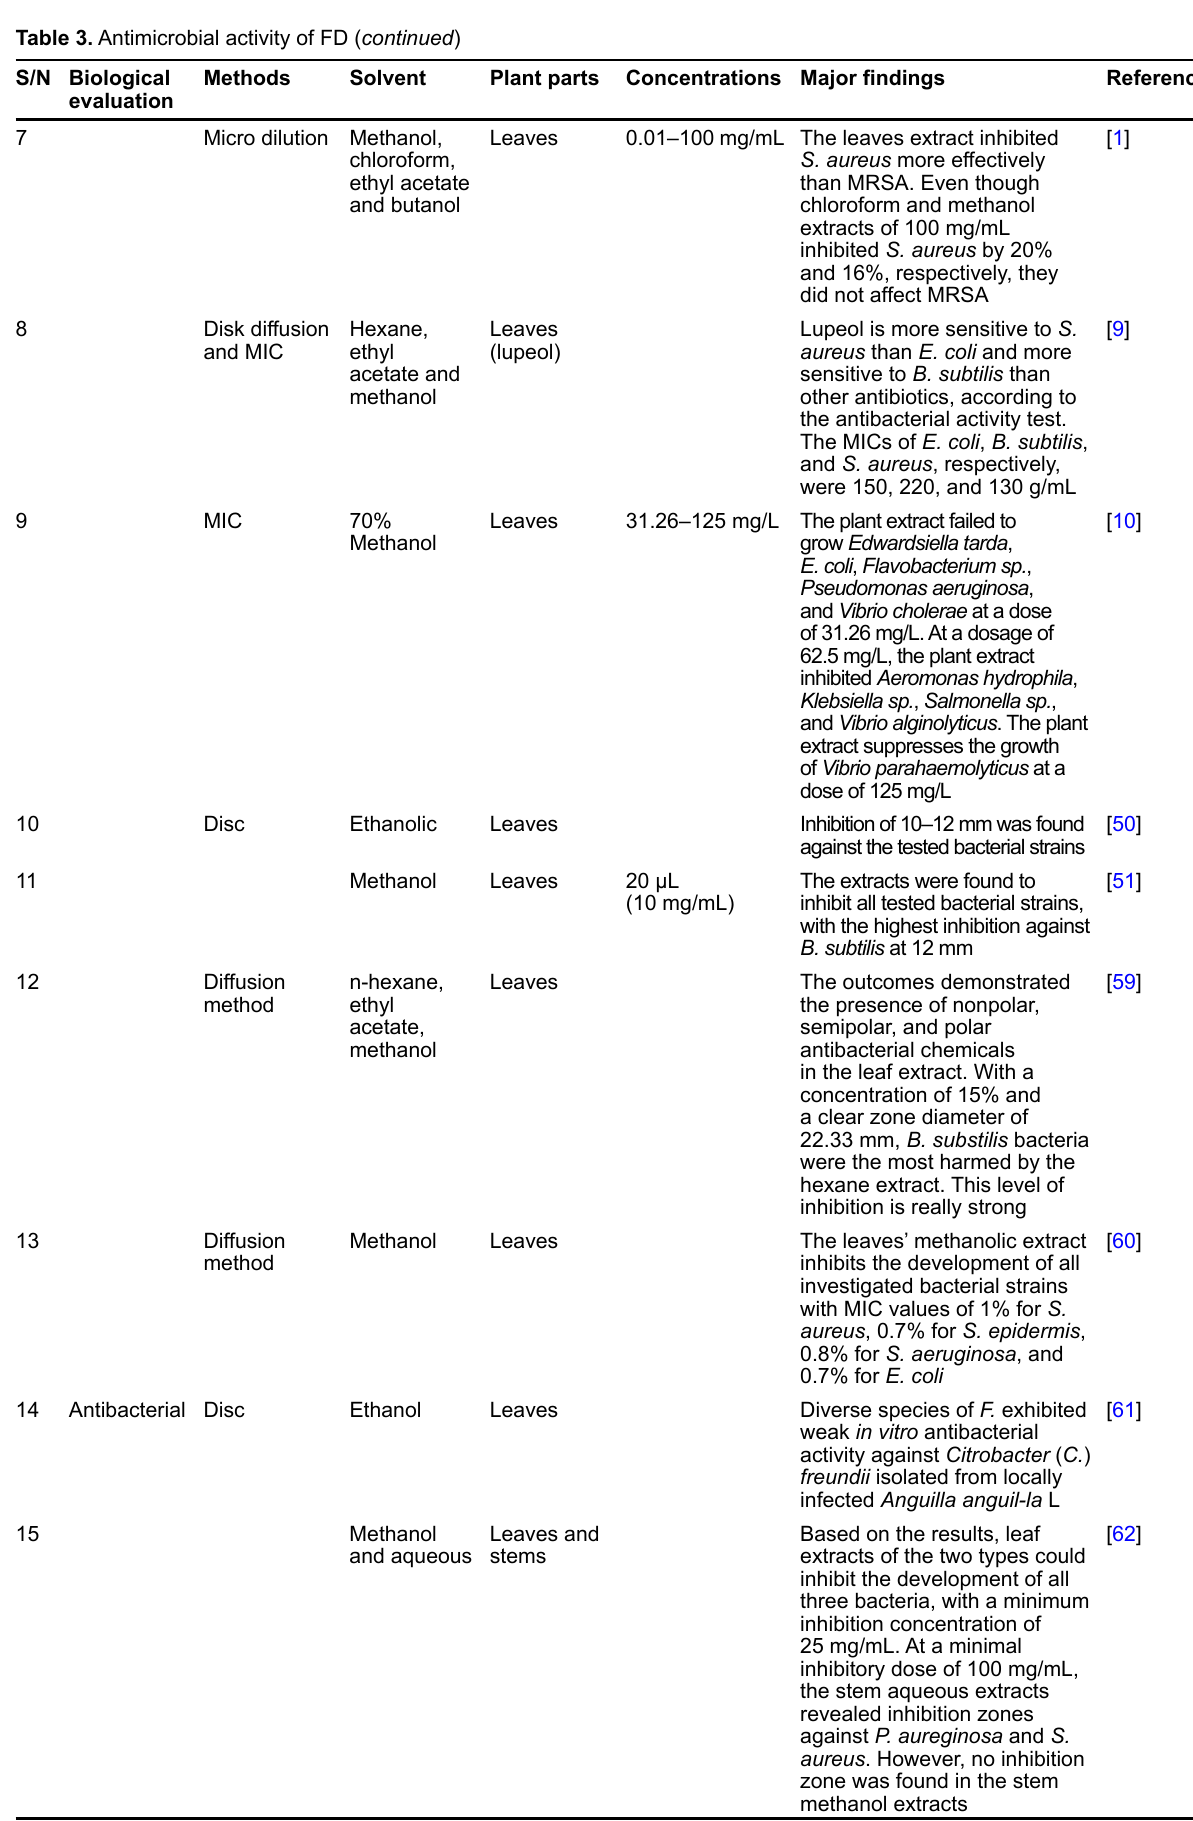
Table 3. Antimicrobial activity of FD ( continued ) S/N Biological